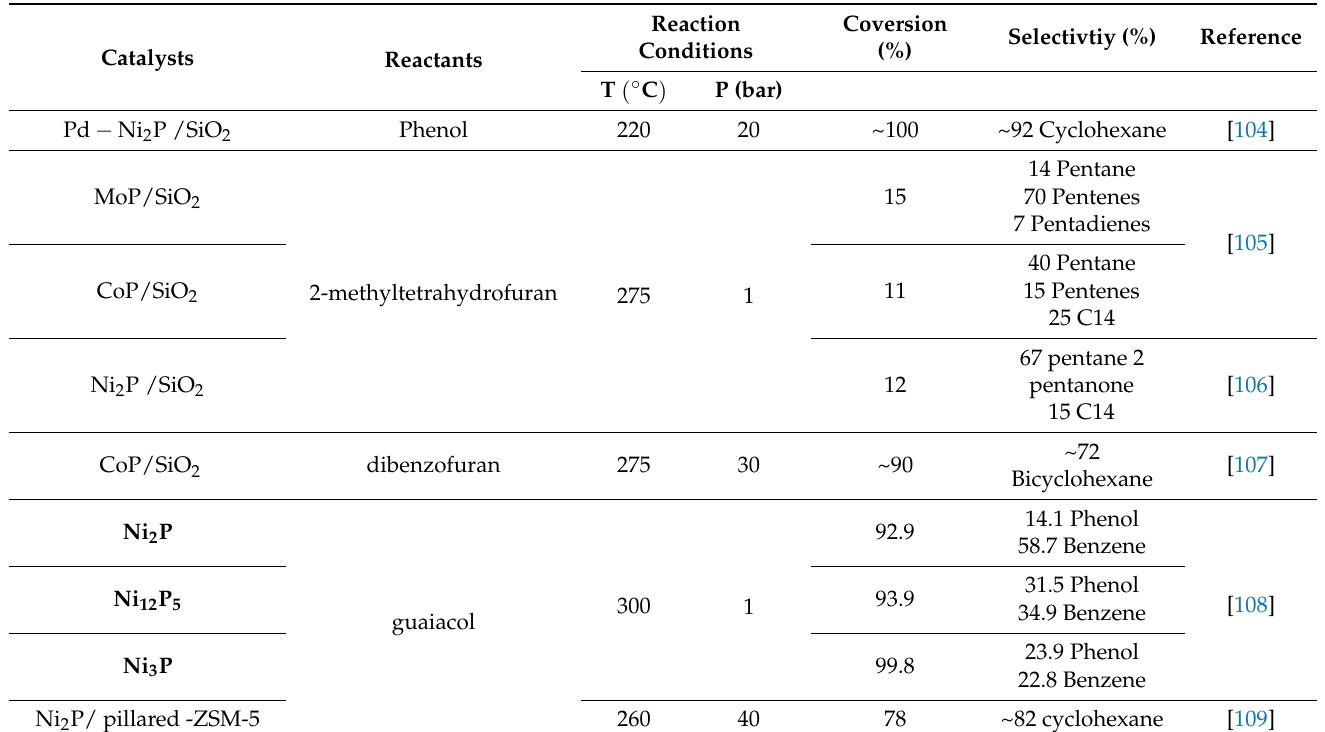
Figure 5. Colloidal synthesis of ternary TMPs. Adapted from Ref [41], ( a ) reaction of a phosphorus precursor (P) with both transition metal sources (M1 and M2), ( b ) Thermal decomposition of a single precursor consisting of phosphorus and both metals, ( c ) generation of bi-metallic nanoparticles their subsequent phosphorisation reaction, ( d ) generation of oxidic nanoparticles and their subsequent phosphorisation. Table 4. The catalytic performance of different TMPs catalysts used in deoxygenation reactions of various reactants.